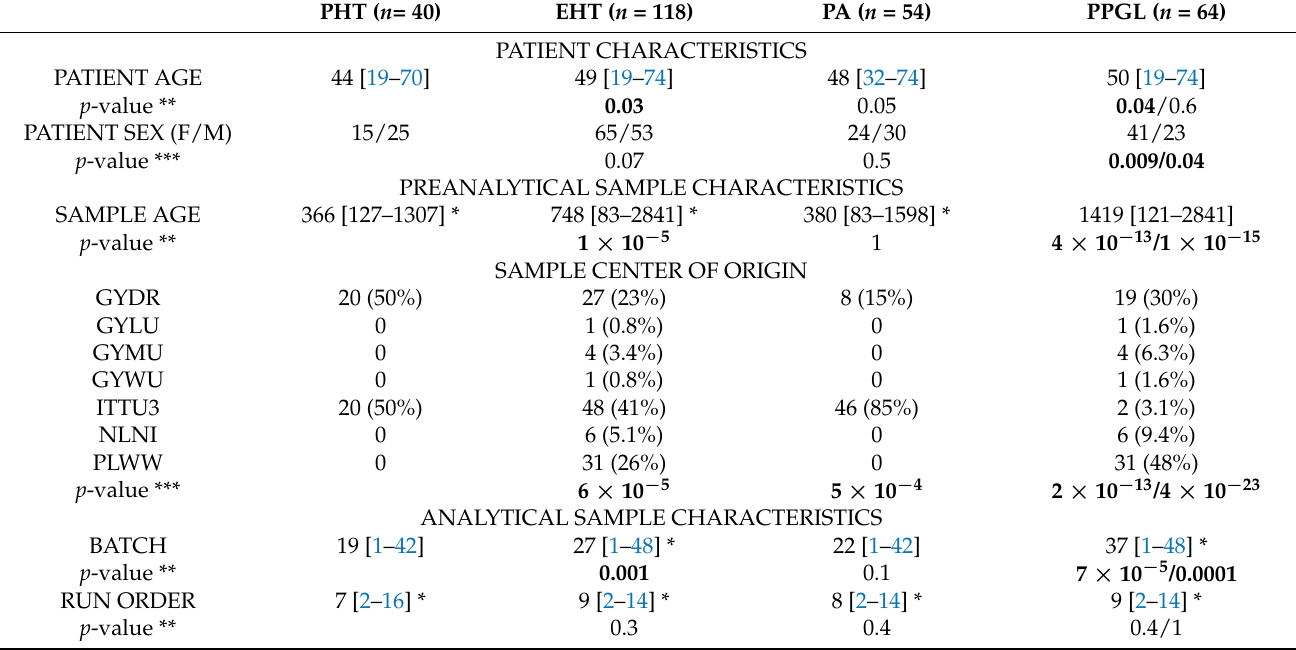
Table 5. Patient and sample characteristics, after whole center exclusions (Approach C). Abbreviations are explained in the main